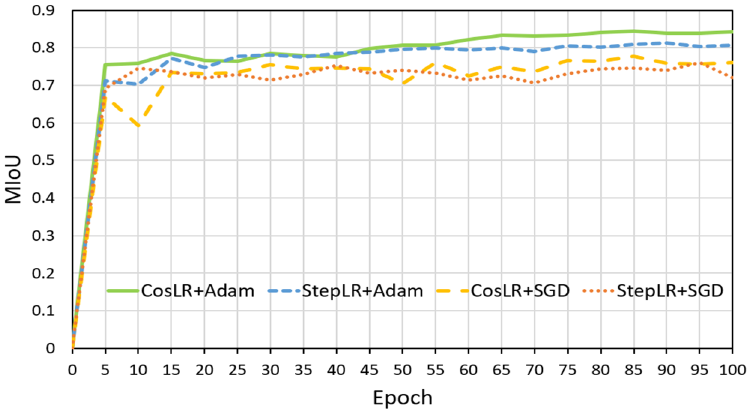
Figure 8. Effects of different learning rate decay methods on the optimizer.